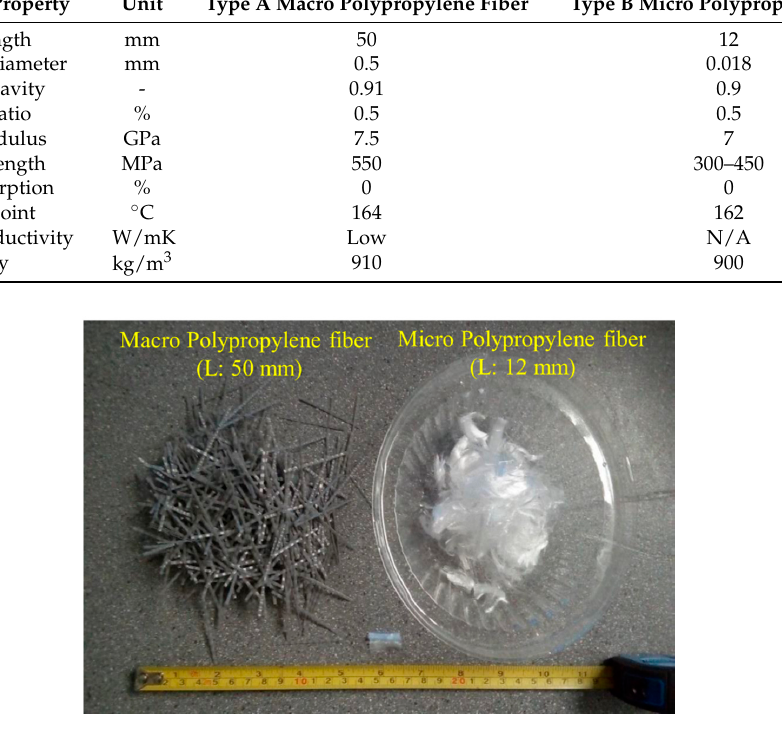
Figure 2. Macro ( left ) and micro ( right ) polypropylene fibers. Figure 2. Macro (left) and micro (right) polypropylene